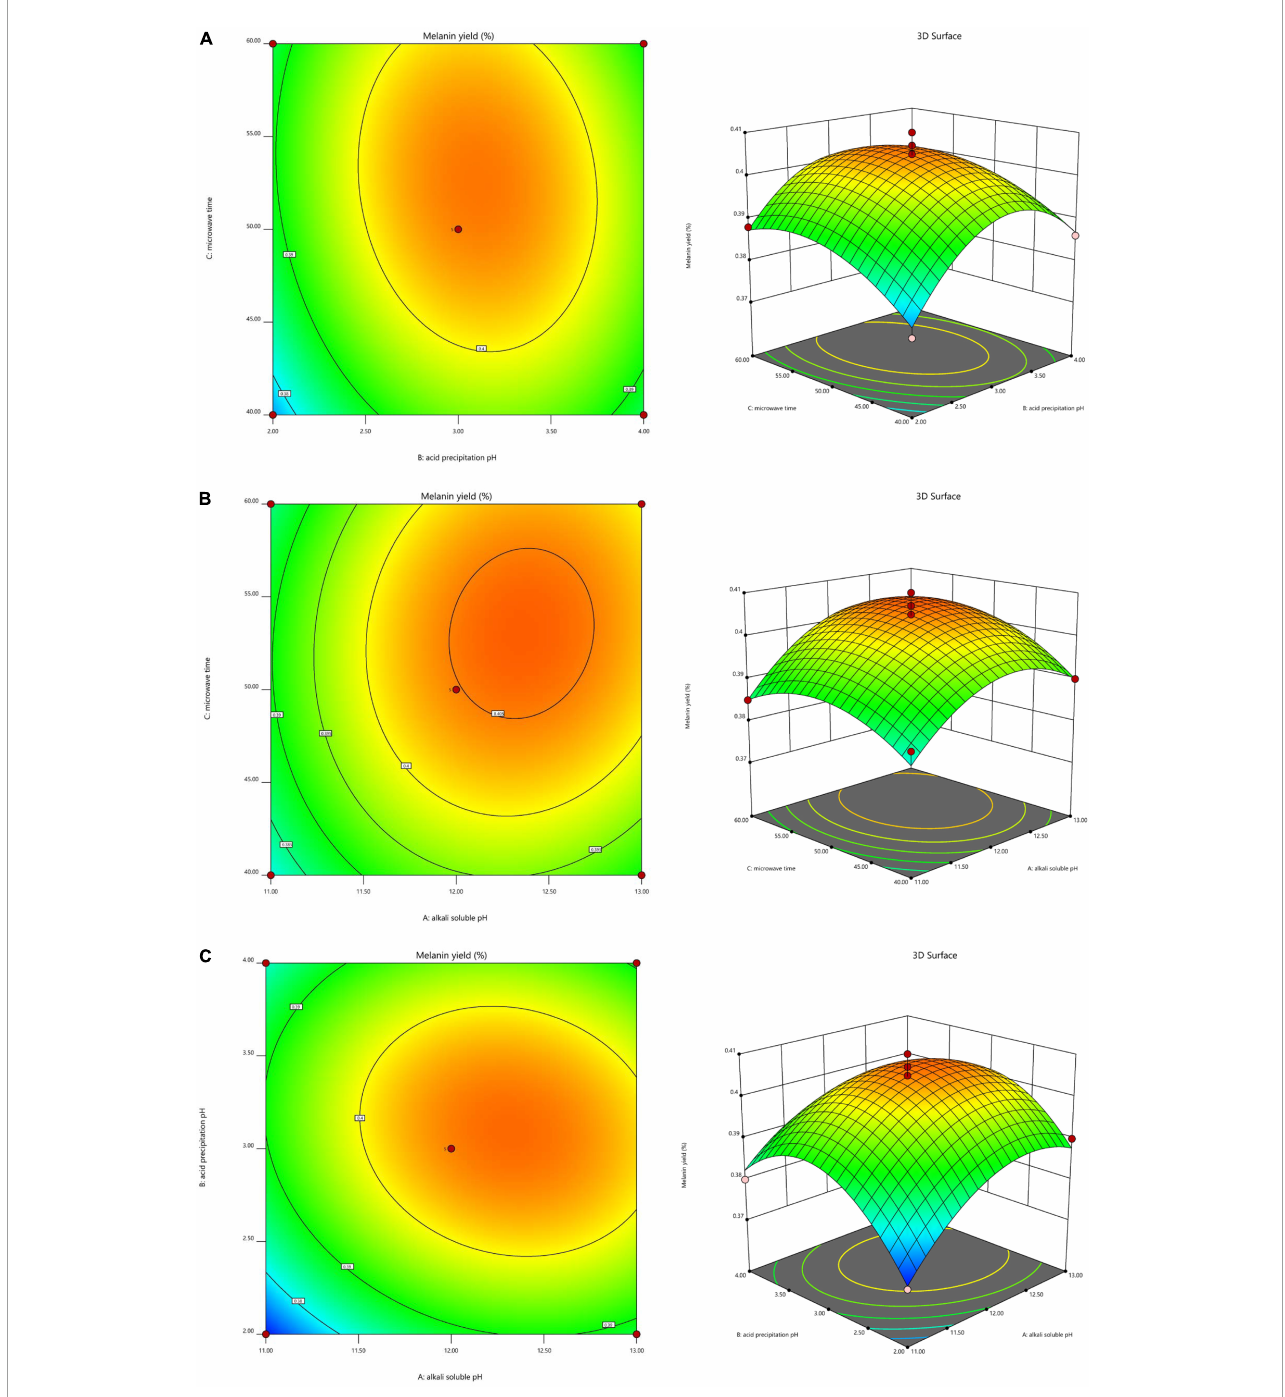
FIGURE2 Interaction effects of the three factors that significantly affect A. heimuer melanin (AHM) yield. The 3D response surface map and 2D contour map reveal the optimal levels of alkali-soluble pH, acid precipitation pH, and microwave time on AHM yield based on the interaction effects of these variables at constant alkali-soluble pH (A) , constant acid precipitation pH (B) , and constant microwave time (C) .